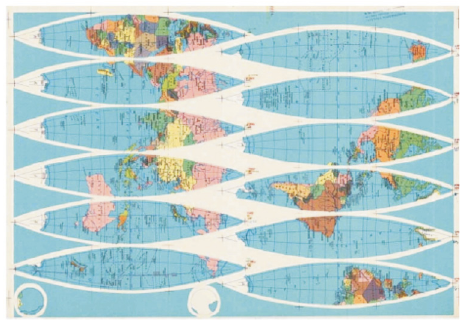
Fig. 10. The stripes for a globe in the Cassini-Soldner projection (M. Gede 2009)